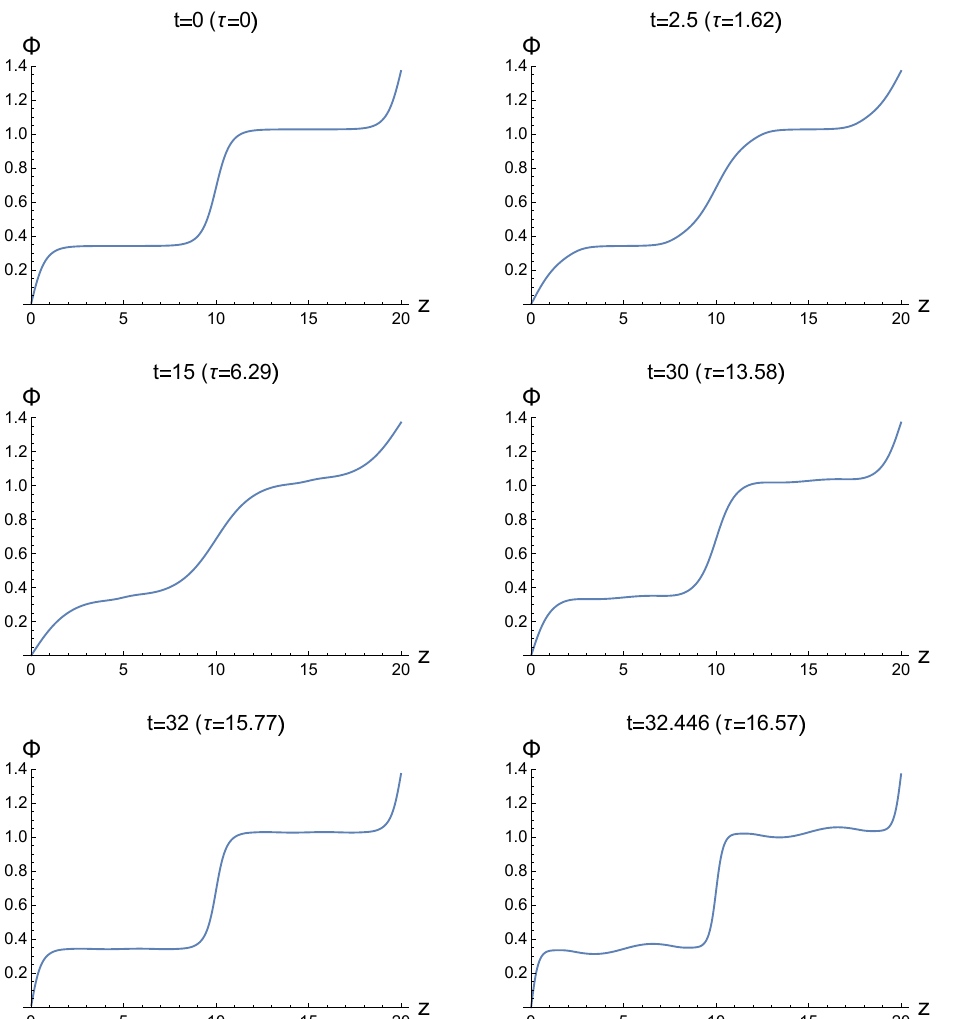
Figure 9 . The profiles of Φ at various times. The parameters are chosen as (4.6) and V min = − 0 . 05